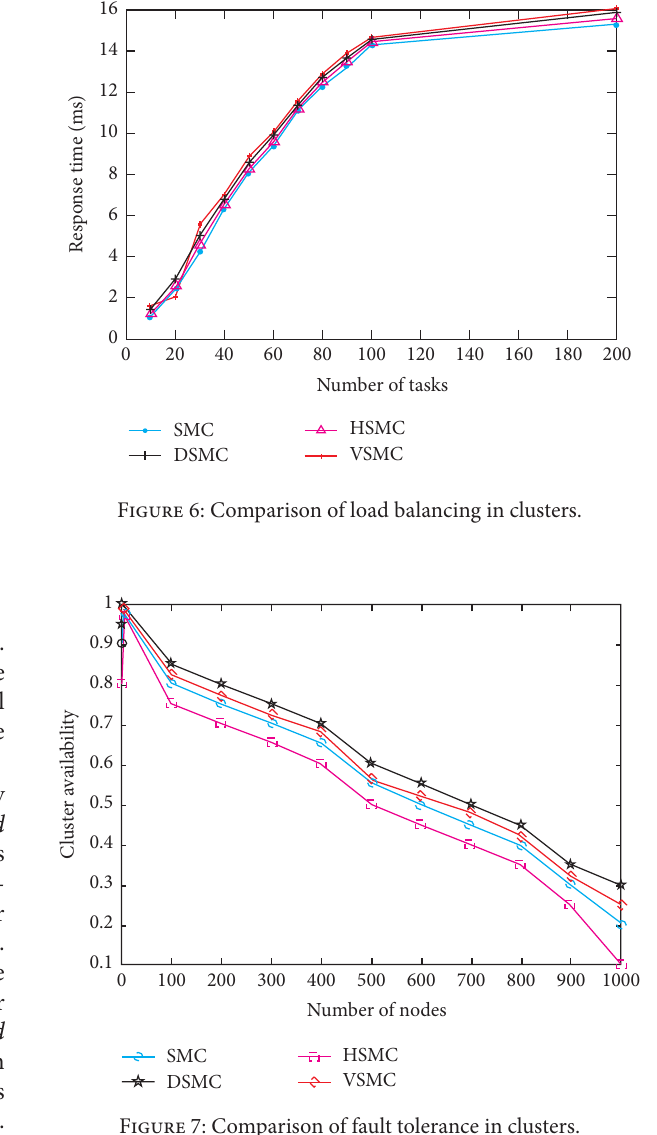
Figure 7: Comparison of fault tolerance in